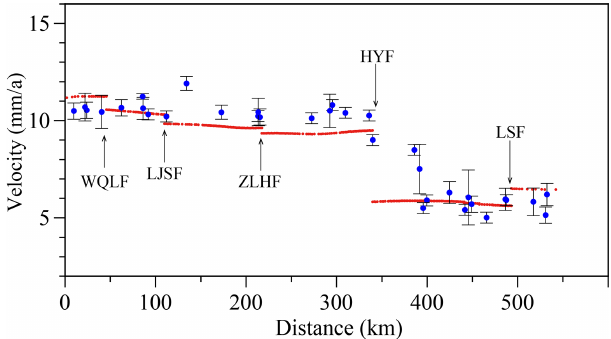
Figure 12. Comparison of the modeled horizontal velocities and GPS velocities along the C–C (cid:48) profile in Fig. 11. The red points are model data, and blue circles indicate GPS measurements. The fault names are defined in Fig.